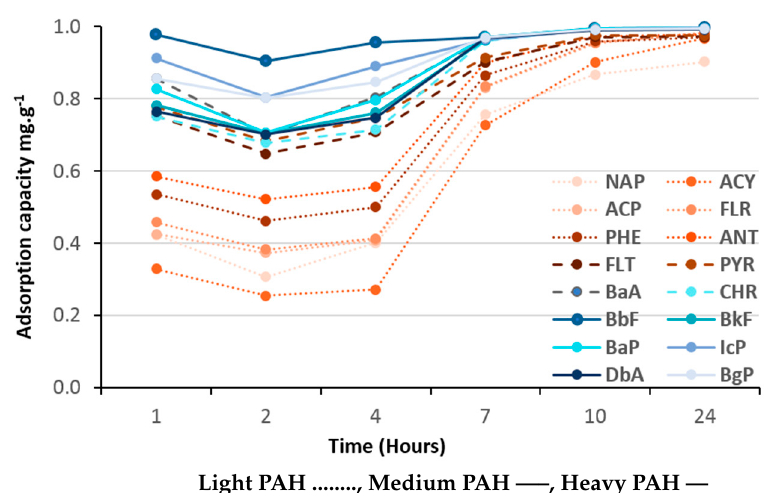
Figure 10. Adsorption kinetics of 16 PAHs on (TiO 2 ) 100